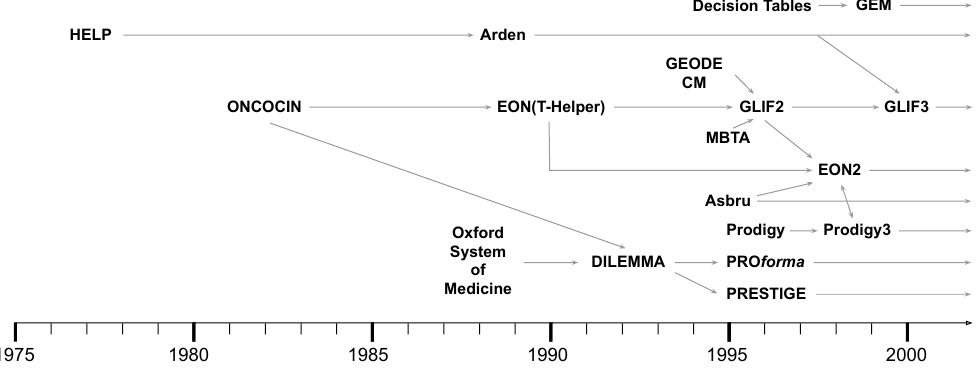
Figure 2. The first era of Computer Interpretable Clinical Guidelines (CIGs). Adapted from the work in